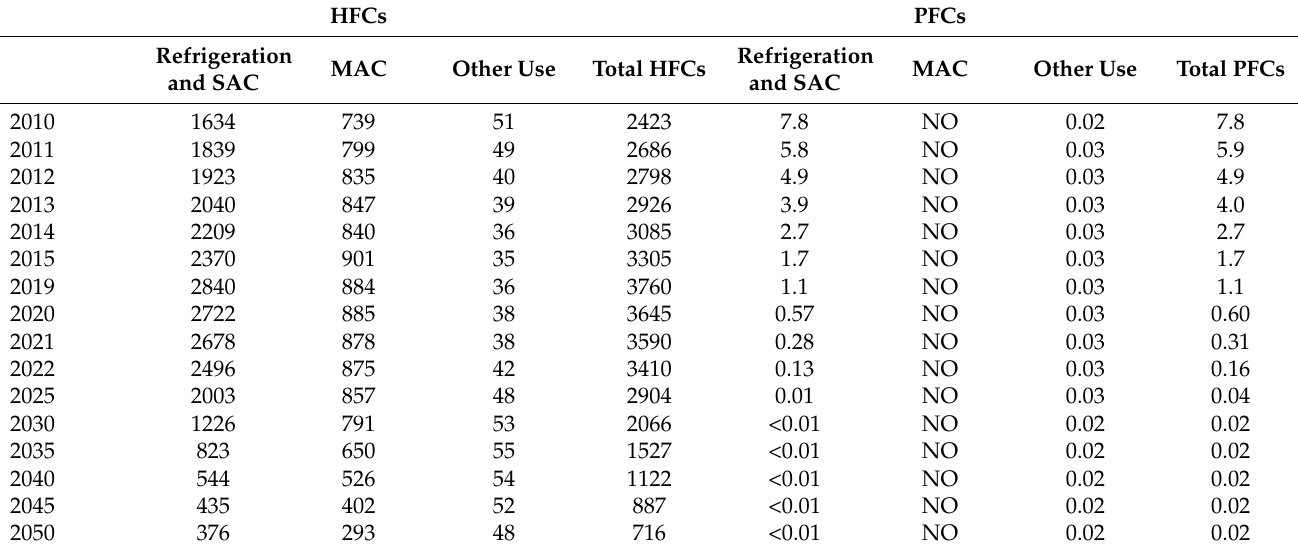
Table 9. HFC and PFC emissions overview (kt CO 2